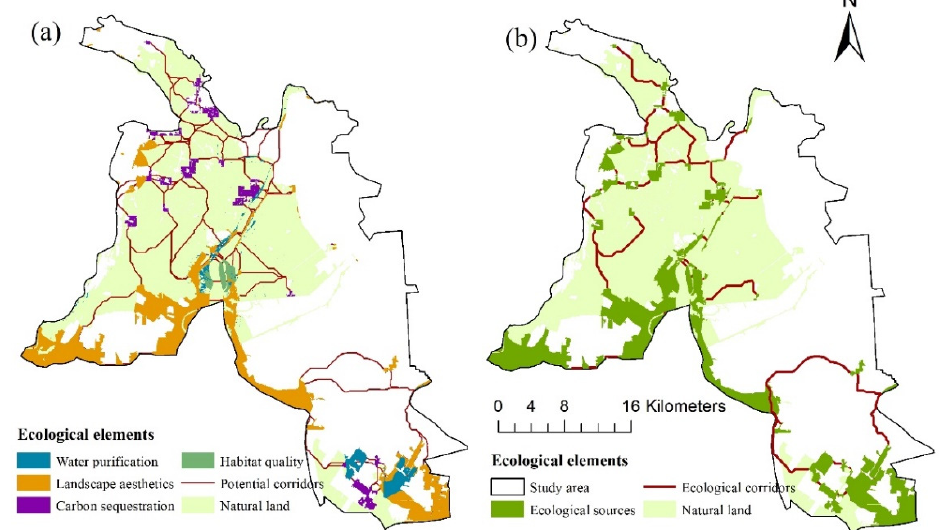
Figure 5. The ESP of the Liao River Delta. ( a ) ESP before connectivity optimization; ( b ) ESP after connectivity optimization.